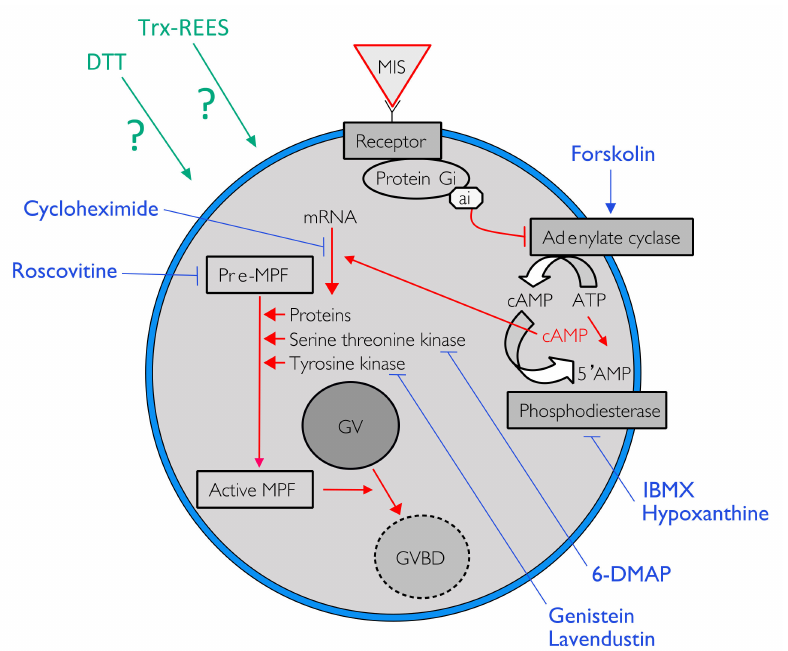
Figure 1. One of the possible pathways to induce oocyte maturation. Signal in red indicated the cytoplasmic pathway activated by the liaison of the maturation-inducing substance (MIS) on his receptor to trigger the resumption of meiosis by the activation of the maturation-promoting factor (MPF). Blue lines indicate action sites of various pharmacological agents tested to inhibit the resumption of oocyte